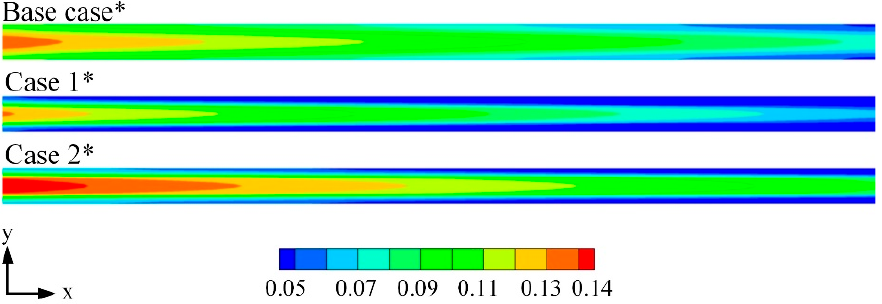
Figure 7. Distribution of oxygen mass fraction at the interface of cathode GDL and CL when the operating voltage is 0.6 V in the Base case*, Case 1* and Case 2*.